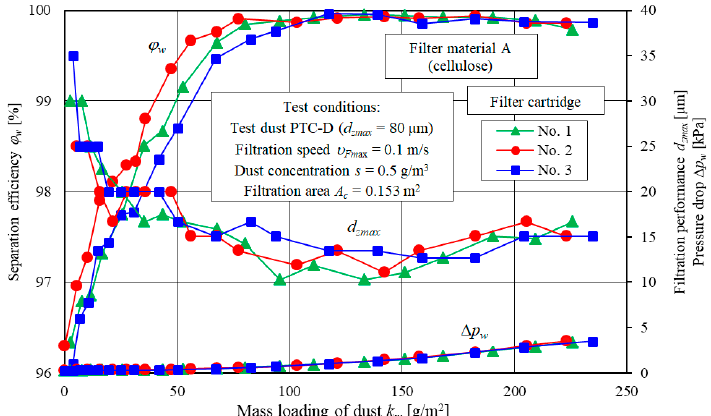
Figure 5. Separation efficiency φ w , filtration performance d zmax and pressure drop Δ p w as a function of dust mass loading k m for three filter elements A specimens.